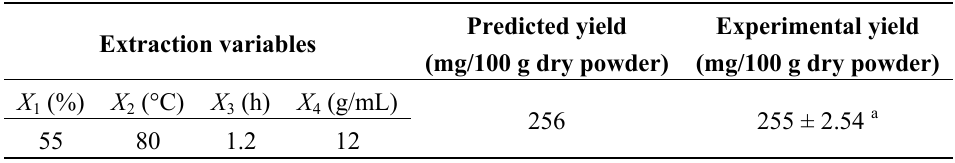
Table 3. Predicted and experimental values of the response under the optimal extraction conditions.